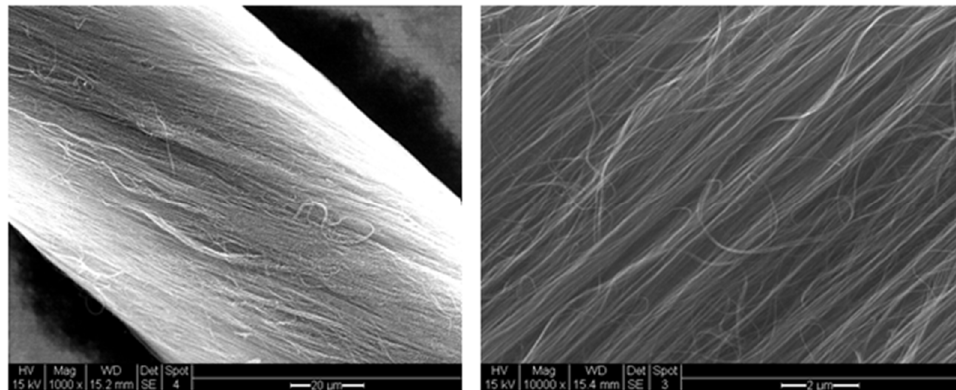
Figure 4. SEM images of carbon nanotube thread.